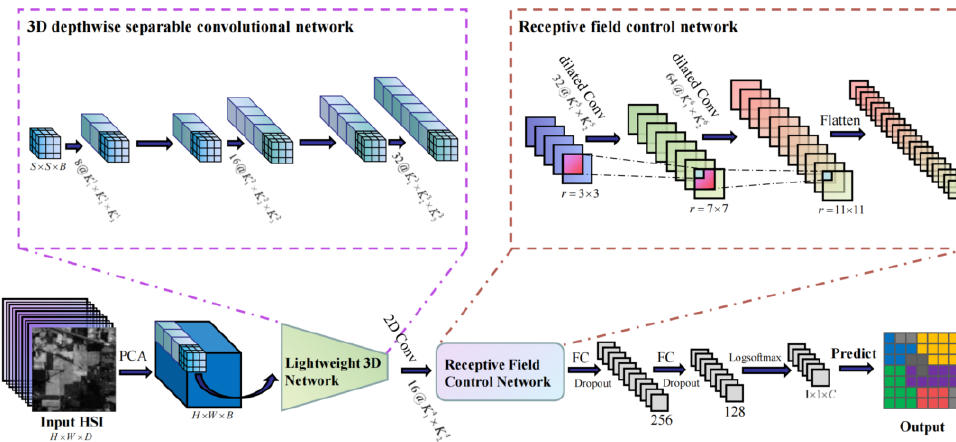
Figure 1. The architecture of the proposed LRCNet.